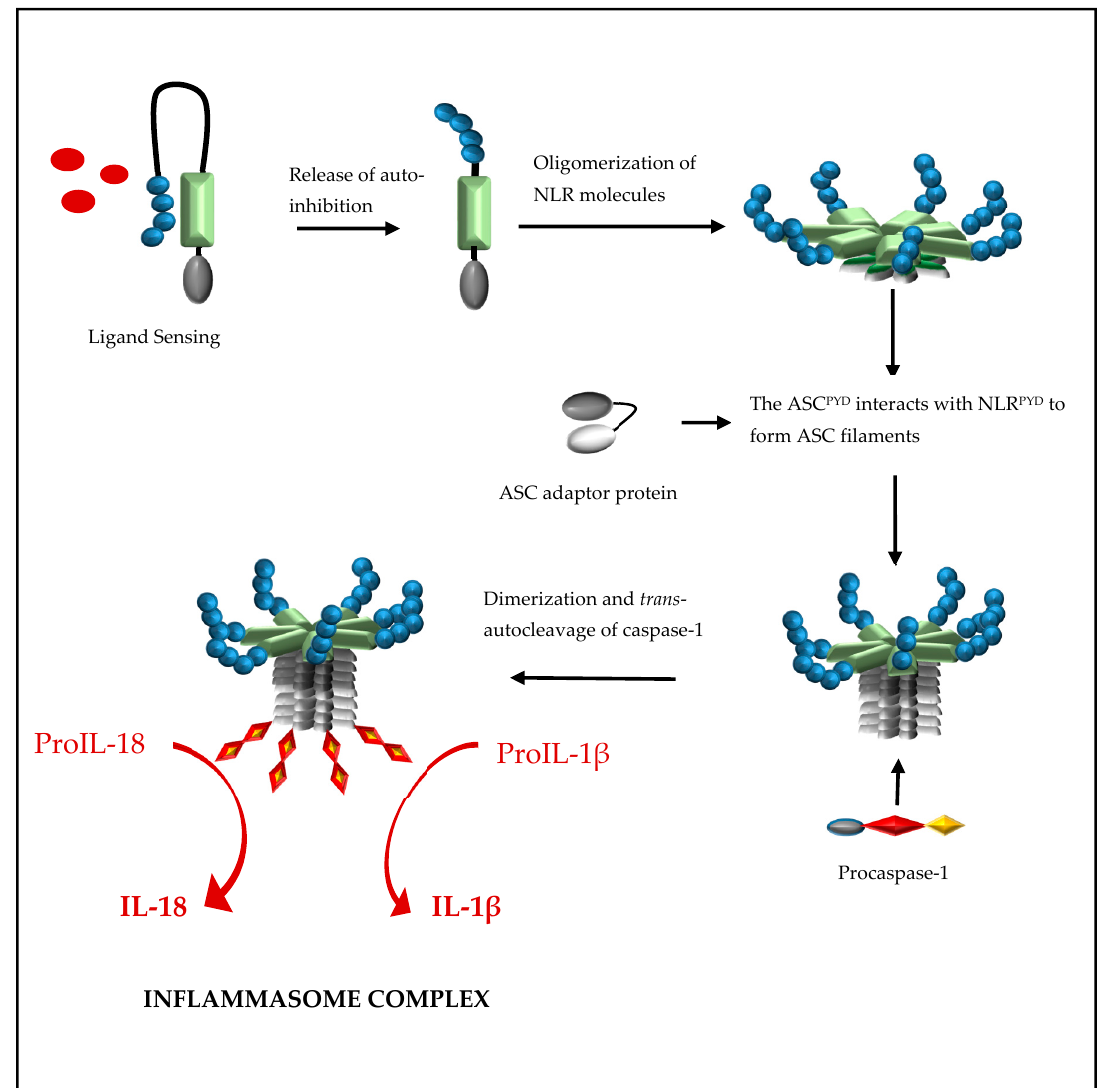
Figure 2. Formation of a NOD-like receptor protein inflammasome containing an N-terminal Pyrin domain.